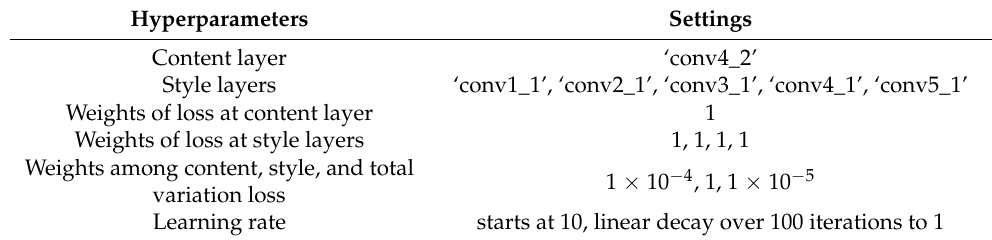
Table 2. Default hyperparameter settings of the model.